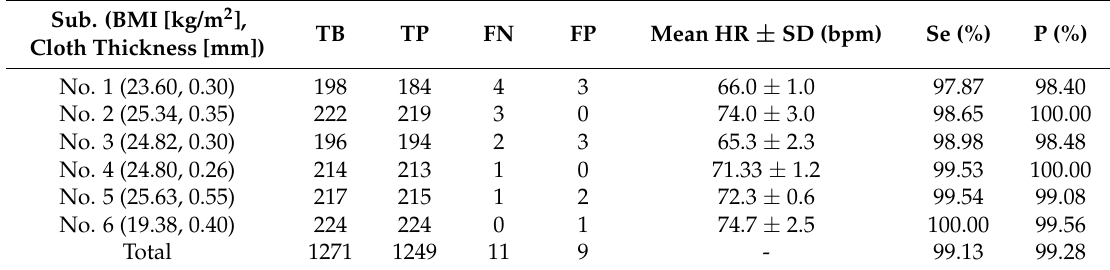
Table 2. Heart beat measurement